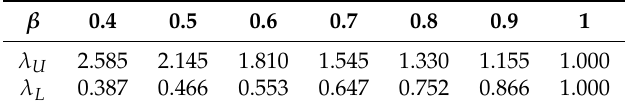
Table 2. Two local decision thresholds λ U and λ L for snr L = 0